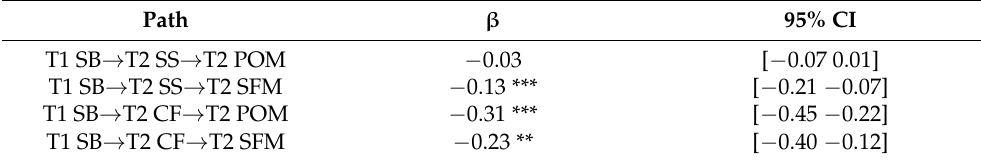
Figure 1. Mediating Model. *** p < 0.001. Table 2. Mediating Effects and Confidence